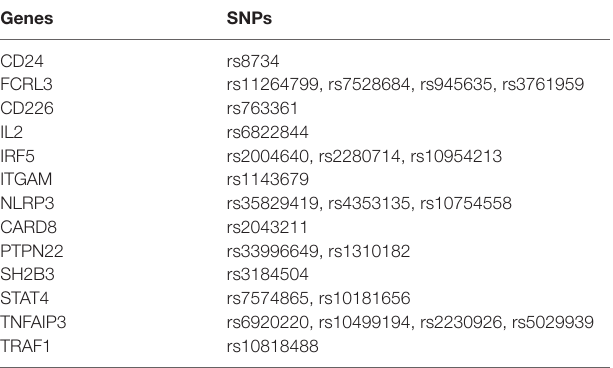
TaBle 2 | Demographic and clinical